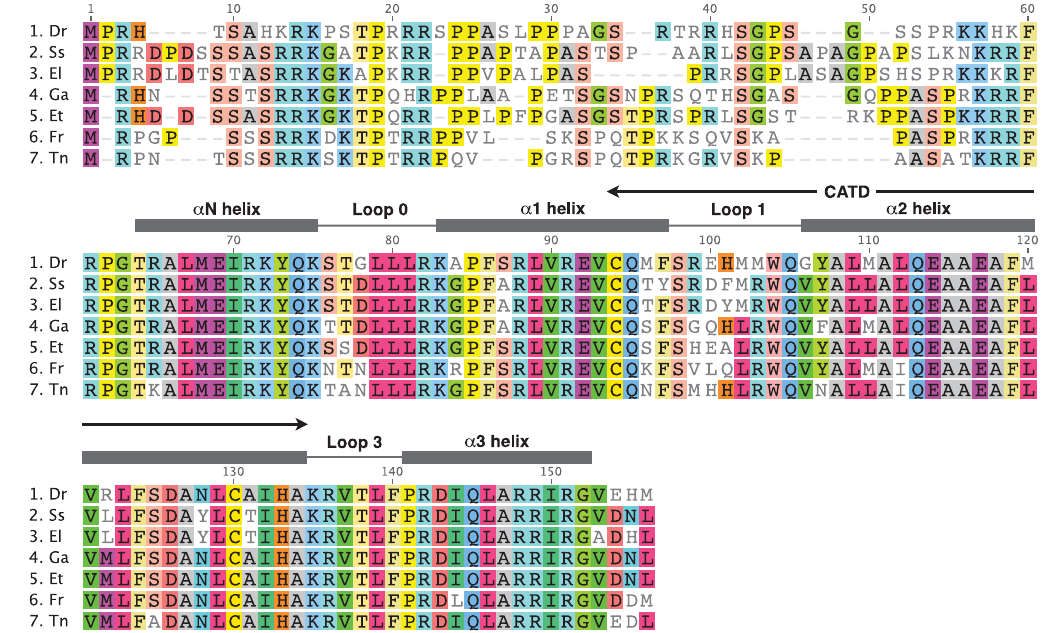
Tn: Tetraodon nigrovirdis